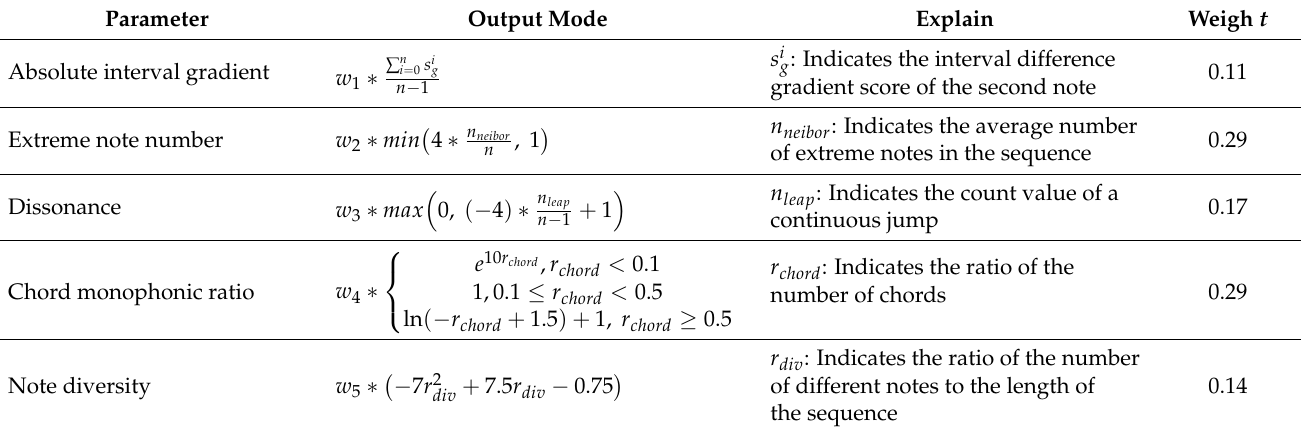
Figure 5. The results generated by the system based on transformer and GANs.